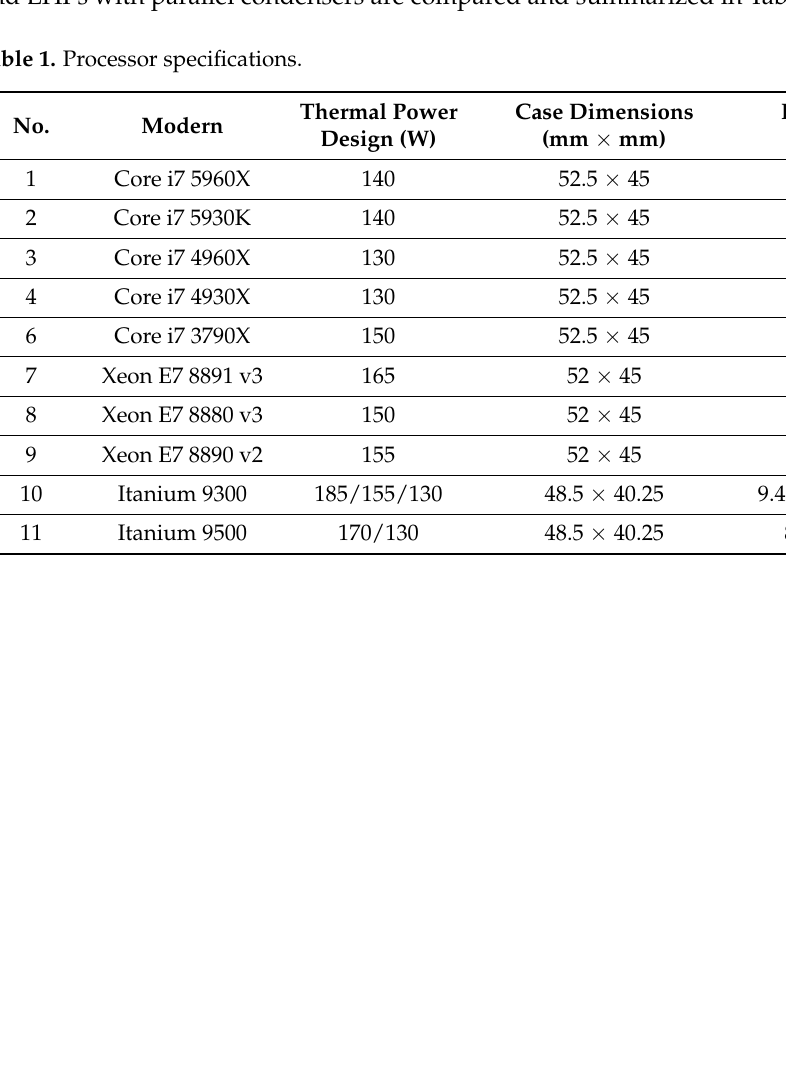
Table 1. Processor Table 1. Processor specifications.